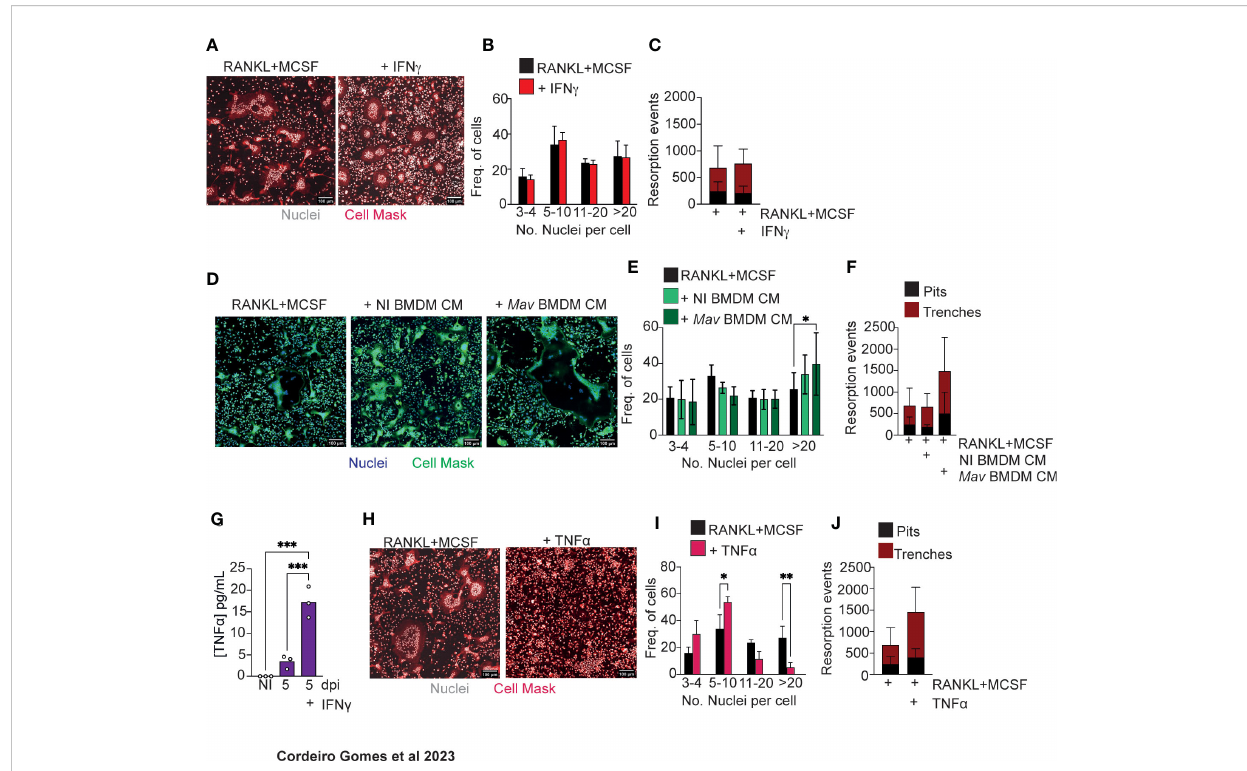
FIGURE 3 Soluble factors produced by M. avium -infected macrophages increase osteoclastogenesis. (A) Osteoclast differentiation in the presence of saturating amounts of M-CSF and RANKL (left panel) and with the addition of 1 ng/mL of IFN g . (B) Frequency of multinucleated cells grouped by number of nuclei per cell. Data are pooled from three independent experiments. Bars represent the average ± standard deviation of the three independent experiments. (C) Enumeration of pits (black bars) and trenches (red bars). Data are representative of two independent experiments. Bars represent the average ± standard deviation of 4 replicates in each experimental group. (D) Osteoclast differentiation in the presence of saturating amounts of M-CSF and RANKL (left panel) and with the addition of conditioned media (CM) from non-infected (NI BMDM, middle panel) and M. avium -infected bone marrow-derived macrophages ( Mav BMDM) (right panel). (E) Frequency of multinucleated cells grouped by number of nuclei per cell. Data are pooled from six independent experiments. Bars represent the average ± standard deviation of the six independent experiments. *, p<0.05, by Two- way ANOVA. (F) Enumeration of pits (black bars) and trenches (red bars). Data are representative of two independent experiments. Bars represent the average ± standard deviation of 4 replicates in each experimental group. (G) Measurement of TNF a in conditioned media from bone marrow derived and M. avium infected-macrophages. (H) Osteoclast differentiation in the presence of saturating amounts of M-CSF and RANKL (left panel) and with the addition of TNF a (right panel). (I) Frequency of multinucleated cells grouped by number of nuclei per cell. Data are pooled from four independent experiments. (J) Enumeration of pits (black bars) and trenches (red bars). Data are representative of two independent experiments. Bars represent the average ± standard deviation of the experimental group. *, p<0.05, ** p<0.01, ***p<0.001 by Two-way